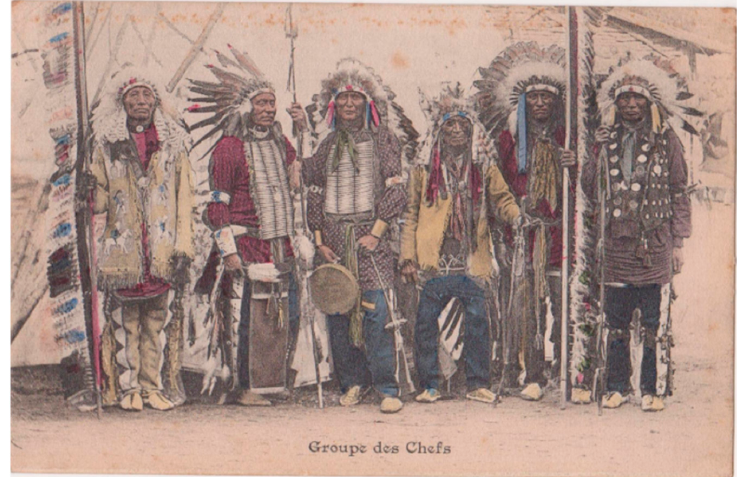
Figure 13. Postcard of “Group of Chiefs” (“Groupe des Chefs” at the Jardin d’Acclimatation, Paris,